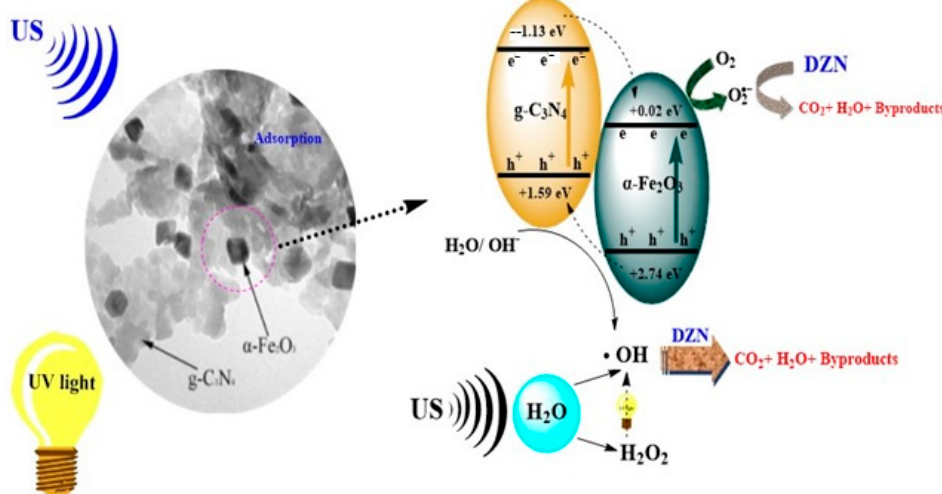
Figure 6. Schematic representation of the mechanism proposed for the α -Fe 2 O 3 /g-C 3 N 4 /UV/US sys- tem.